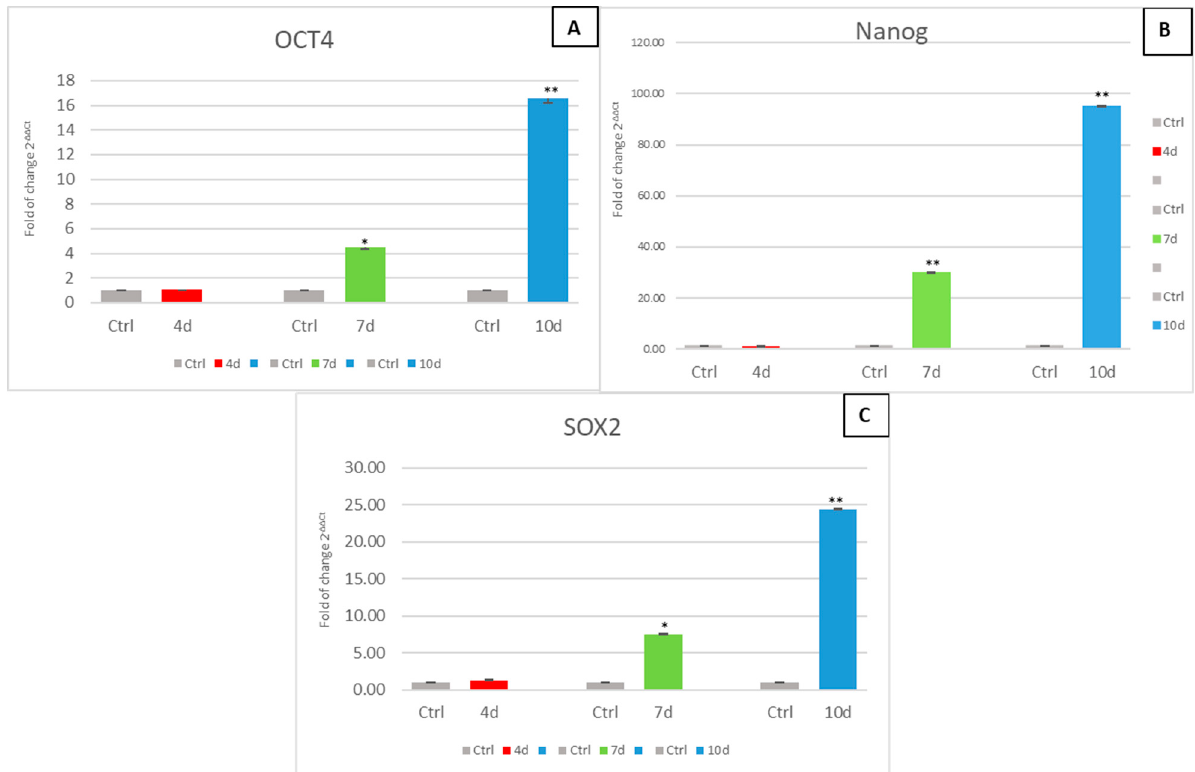
Figure 5. Expression of stemness genes. The expression of stemness-related genes OCT4 (Panel ( A )), Nanog (Panel ( B )), and SOX2 (Panel ( C )) was evaluated in hADSCs cultured with 4d-MCF-7-EM (4d – red bars), 7d-MCF-7-EM (7d – green bars), or 10d-MCF-7-EM (10d – blue bars). The mRNA levels for each gene were normalized to Glyceraldehyde-3-Phosphate-Dehydrogenase (GAPDH) and expressed as fold of change (2 −ΔΔ Ct ) of the mRNA levels observed in untreated control hADSCs (Ctrl - grey bars) defined as 1 (mean ± SD; n = 6). Data are expressed as mean ± SD referred to the control (* p ≤ 0.05), (** p ≤ 0.01).